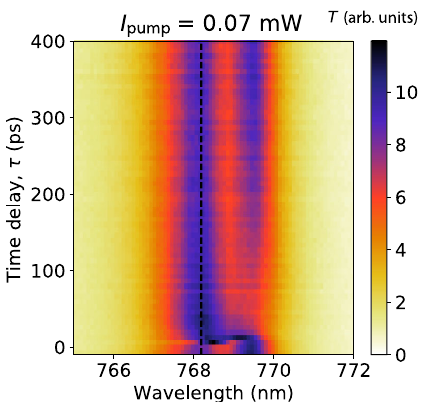
FIG. 10. Transmission ( T ) spectrum of the attractive polaron- polariton when resonantly pumping the UP (indicated by black dashed line) as a function of time delay τ from − 10 to 400 ps at ¼ ð 8 (cid:2) 1 Þ × 10 11 cm − 2 and I ¼ 0 . 07 n e pump